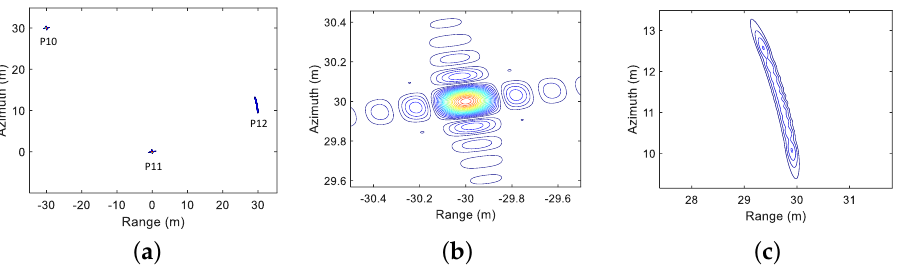
Figure 14. Traditional SAR imaging result of the scene shown in Figure 10a using IETSA. ( a ) entire scene result; ( b , c ) enlarged results of P10 and P12 in ( a ), respectively.